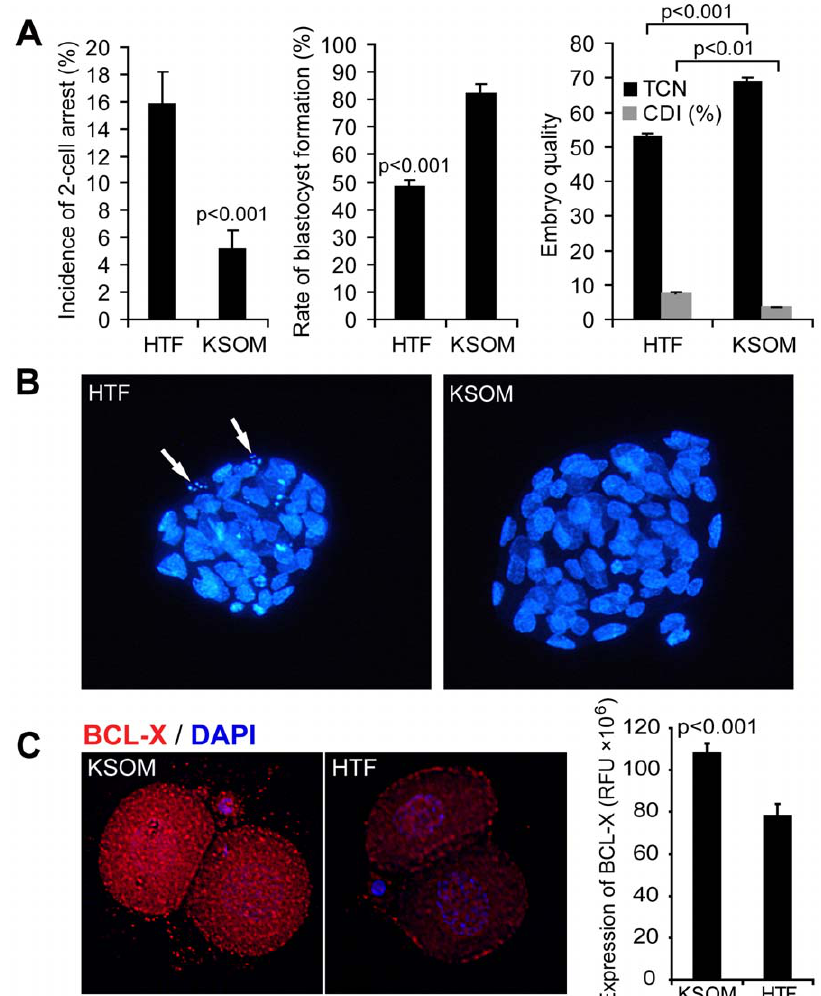
Figure 2. Impact of culture medium on developmental competence and BCL-X protein expression of mouse embryos. (A) HTF culture medium induces 2-cell arrest in a subset of embryos and compromises preimplantation embryo development when compared to KSOM medium (n=273 embryos/medium). Rates of blastocyst formation at day 4.5 ( , 96 hours in culture) as well as total cell number (TCN) are dramatically reduced, while cell death index (CDI) is elevated (n=54 embryos for KSOM and n=36 embryos for HTF). Bars indicate mean 6 s.e.m. Mann Whitney U-test was used for pairwise comparison. (B) Poor quality of embryos is also reflected by nuclear staining (DAPI), showing smaller blastocysts with multiple apoptotic cells (arrows). (C) Expression of BCL-X protein is decreased in 2-cell embryos cultured for 24 hours in HTF medium. Significant reduction in fluorescent intensity (RFU), generated after immunocytochemical analysis for BCL-X was detected in embryos cultured in HTF (n=10), when compared to KSOM cultured embryos (n=9). Control embryos, exposed to no-specific IgG (n=6), exhibited only very small amount of fluorescence, which was subtracted from the intensity generated by BCL-X antibody. Bars indicate mean 6 s.e.m. Student’s t-test was used for calculating significance of difference between KSOM and HTF